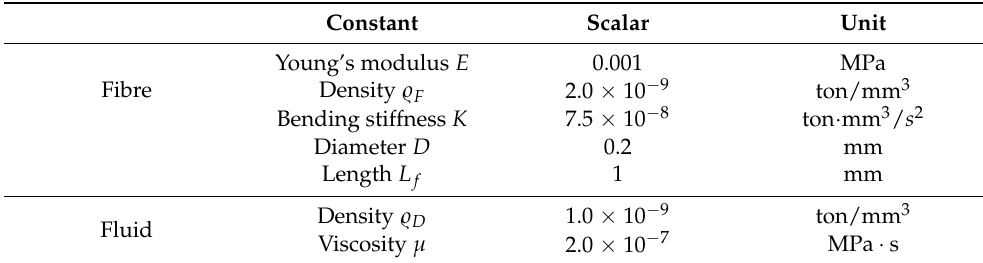
Figure 18. Numerical setup for the validation model. ( a ) Initial configuration. ( b ) Mesh division of the validation model. Table 10. Material parameter of the validation